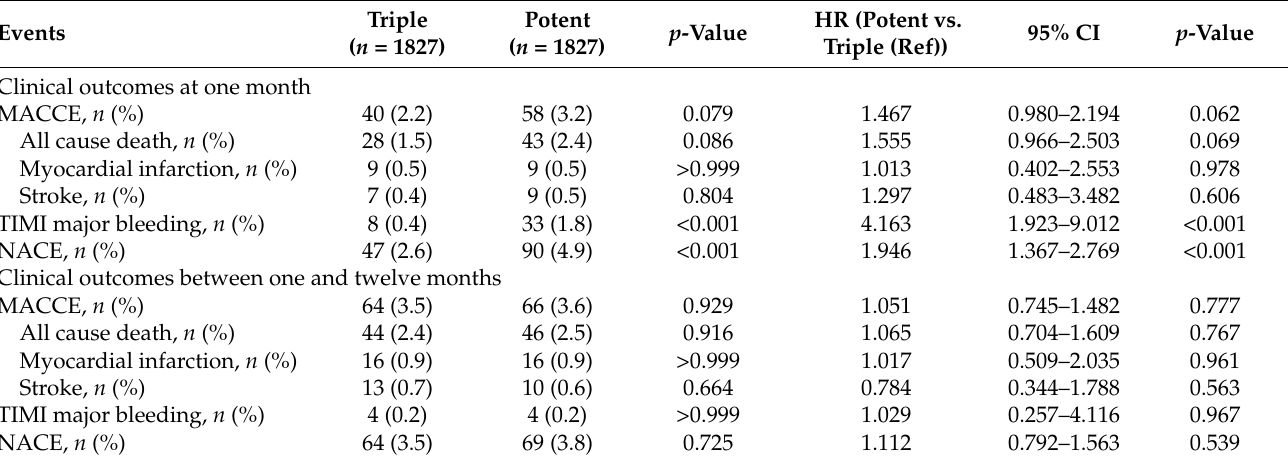
Table 4. Clinical outcomes and independent risk for clinical events by propensity score matching